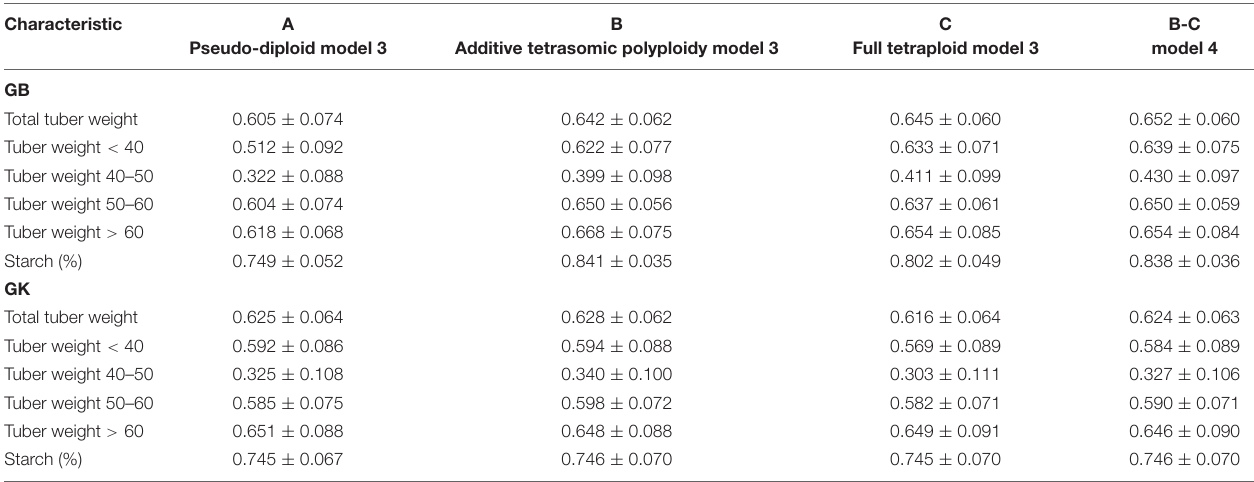
TABLE 7 | Multi-environment, genomic best linear unbiased predictor BLUP (GBLUP), and Gaussian-kernel prediction accuracy ( ± standard deviation) for potato tuber characteristics considering pseudo-diploid (A) (model 3), additive tetrasomic polyploid (B) (model 3), full tetraploid (C) (model 3), and B-C (model 4) with fourfold partitions of 10 random samples each in Umeå 2020 ( N =